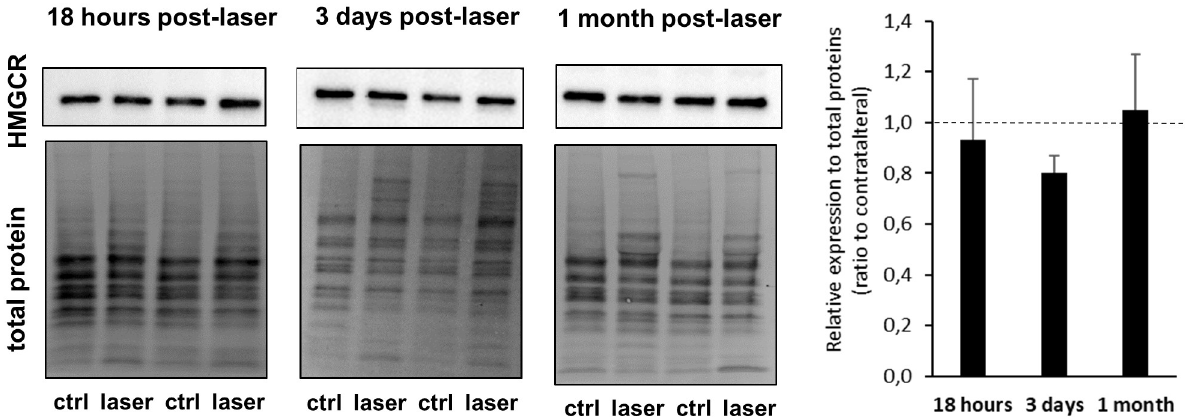
Fig 5. Protein expression of HMGCR was unchanged in response to the laser procedure. HMGCR (97 kDa) expression was measured using Western Blot on retinas collected at 18 hours, 3 days or 1 month after laser photocoagulation. Protein signal intensity was normalized to total protein using the stain free technology (BioRad). Representative blots are shown. Results are expressed as ratio to contralateral and represented as mean ± S. D, n = 4–7 retinas. No statistical significance with the Wilcoxon matched-pairs signed rank test.